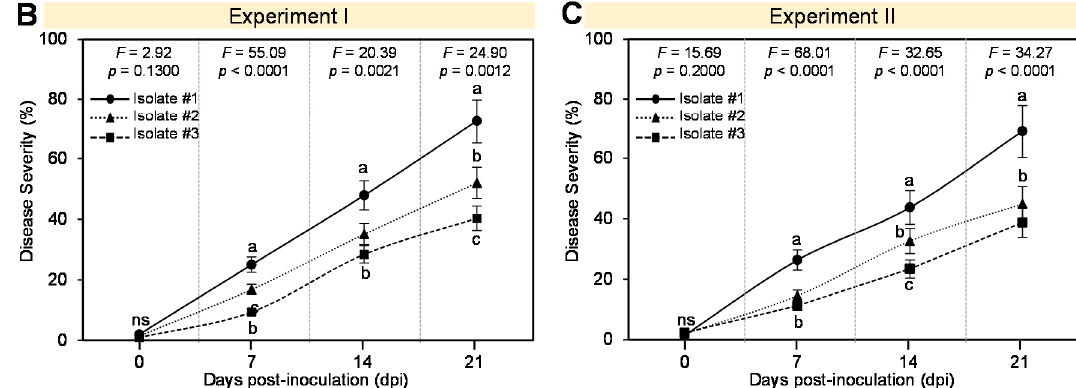
Figure 1. Pathogenicity test of di ff erent isolates of A. solani on tomato plants (Super strain B–F 1 hybrid) under greenhouse conditions ( n = 6). ( A ) Typical symptoms of early blight disease on tomato leaves after the infection with di ff erent isolates of A. solani . ( B , C ) Disease severity (%) of di ff erent isolates of A. solani in two separate experiments. Values represent the mean of six replicates ± standard deviation (Means ± SD). Di ff erent letters indicate statistically significant di ff erences among treatments, while “ns” or the same letter signify no significant di ff erences among treatments at the same time point using the Tukey–Kramer honestly significant di ff erence test (Tukey HSD; p < 0.05). The experiment was repeated twice with similar results.